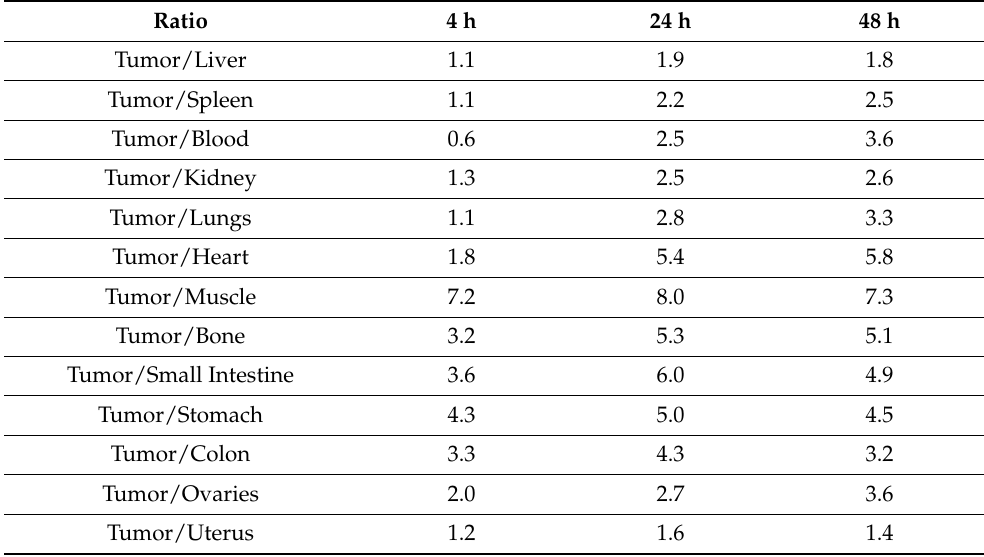
Table 2. Tumor-to-organ ratio of [ 64 Cu]Cu-1C1m-Fc determined by biodistribution of group 1 at 4 h, 24 h and 48 h.